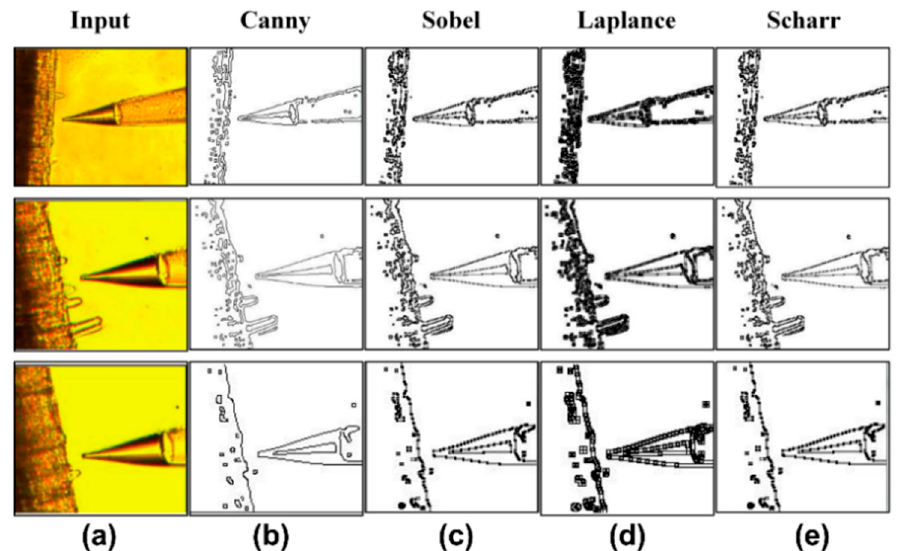
Figure 14. The results of edge detection of various image edge detection techniques. ( a ) Input images; ( b ) Canny edge detection results; ( c ) Sobel edge detection results; ( d ) Laplace edge detection results; and ( e ) Scharr edge detection results.